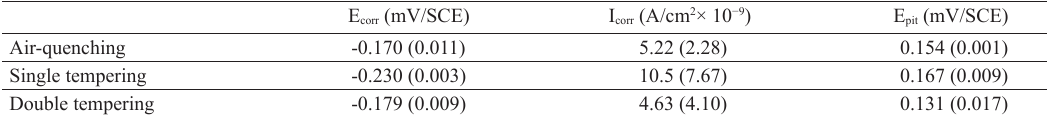
Table 3. Potentiodynamic polarization test